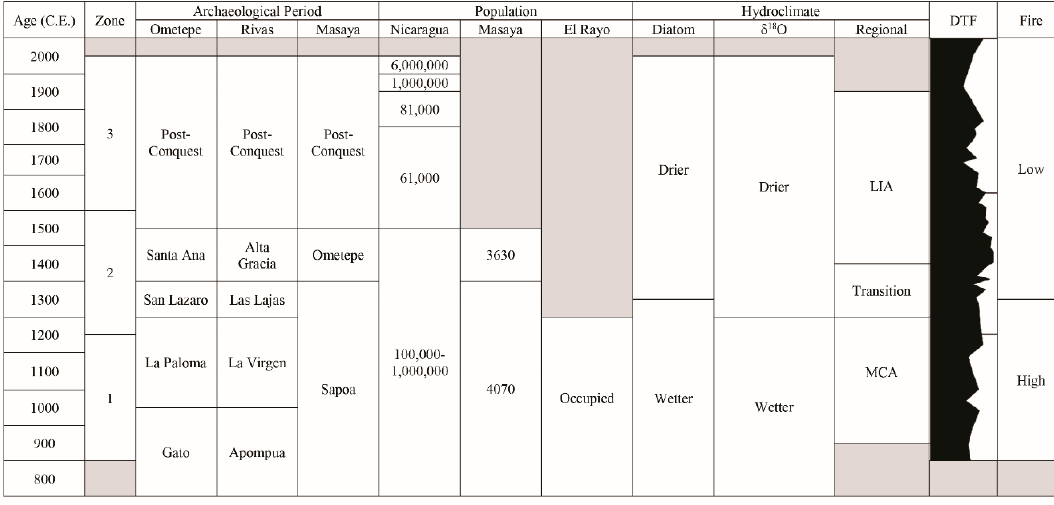
Table S1: Images of diatom taxa at 400x magnification identified from El Gancho, Table S2: Images of palynological taxa at 400x magnification identified from El Gancho, Figure S1: Amaranthus spinosus field specimen.